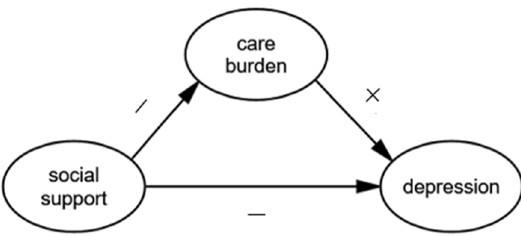
Figure 1. The theoretical model and hypotheses.